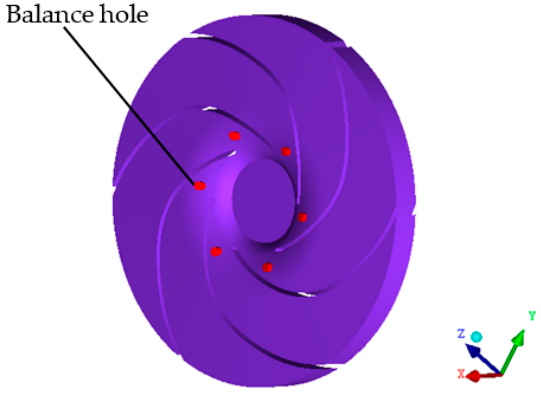
Figure 6. Physical model of the impeller.